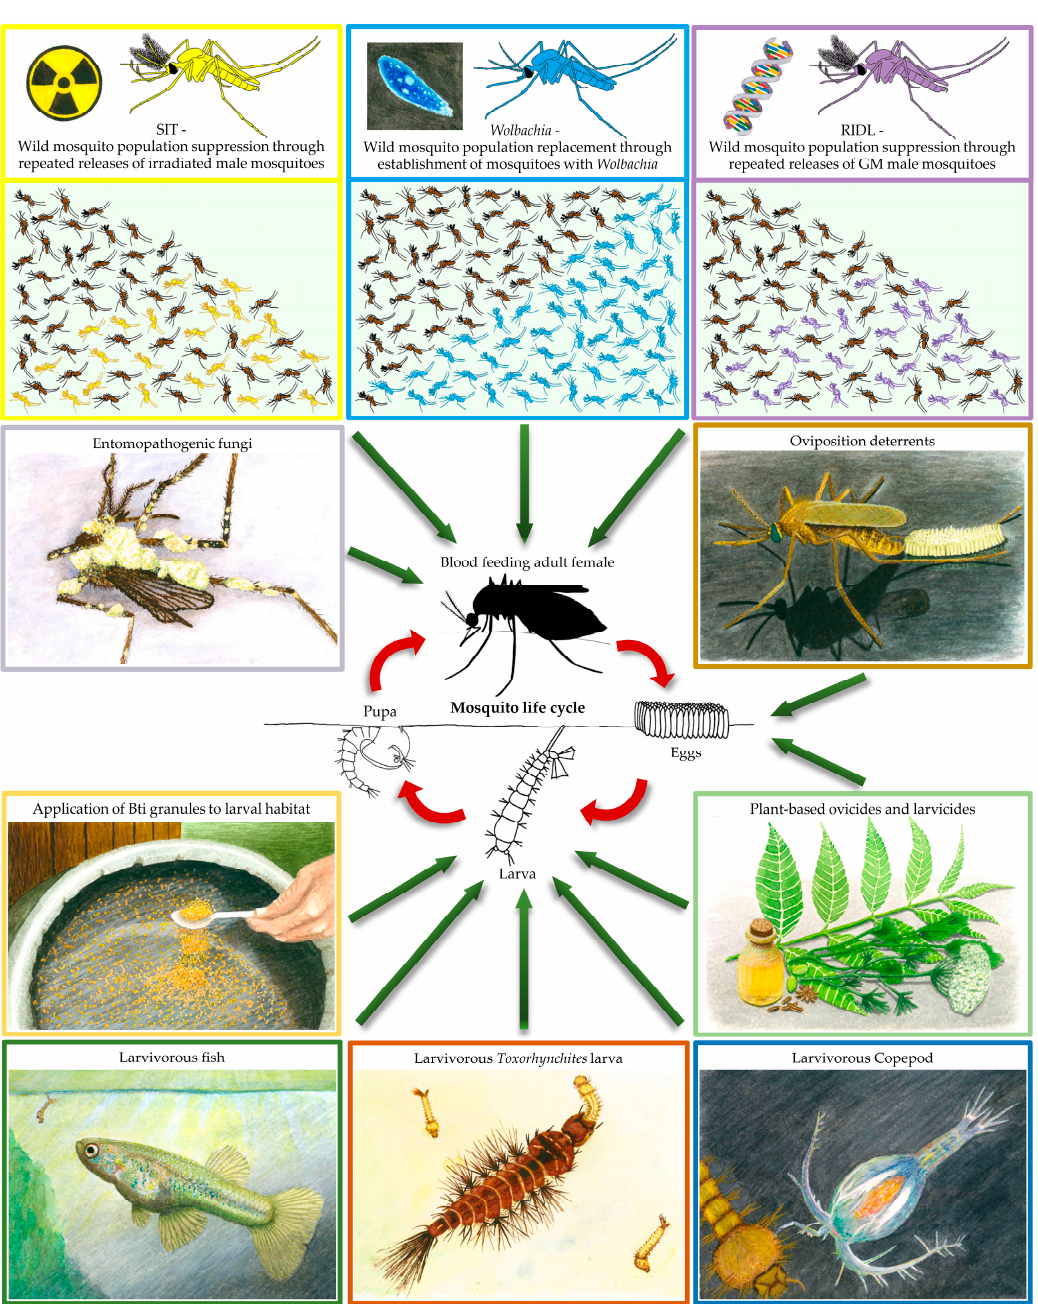
Figure 1. Mosquito biocontrol strategies targeting different stages of the mosquito lifecycle.